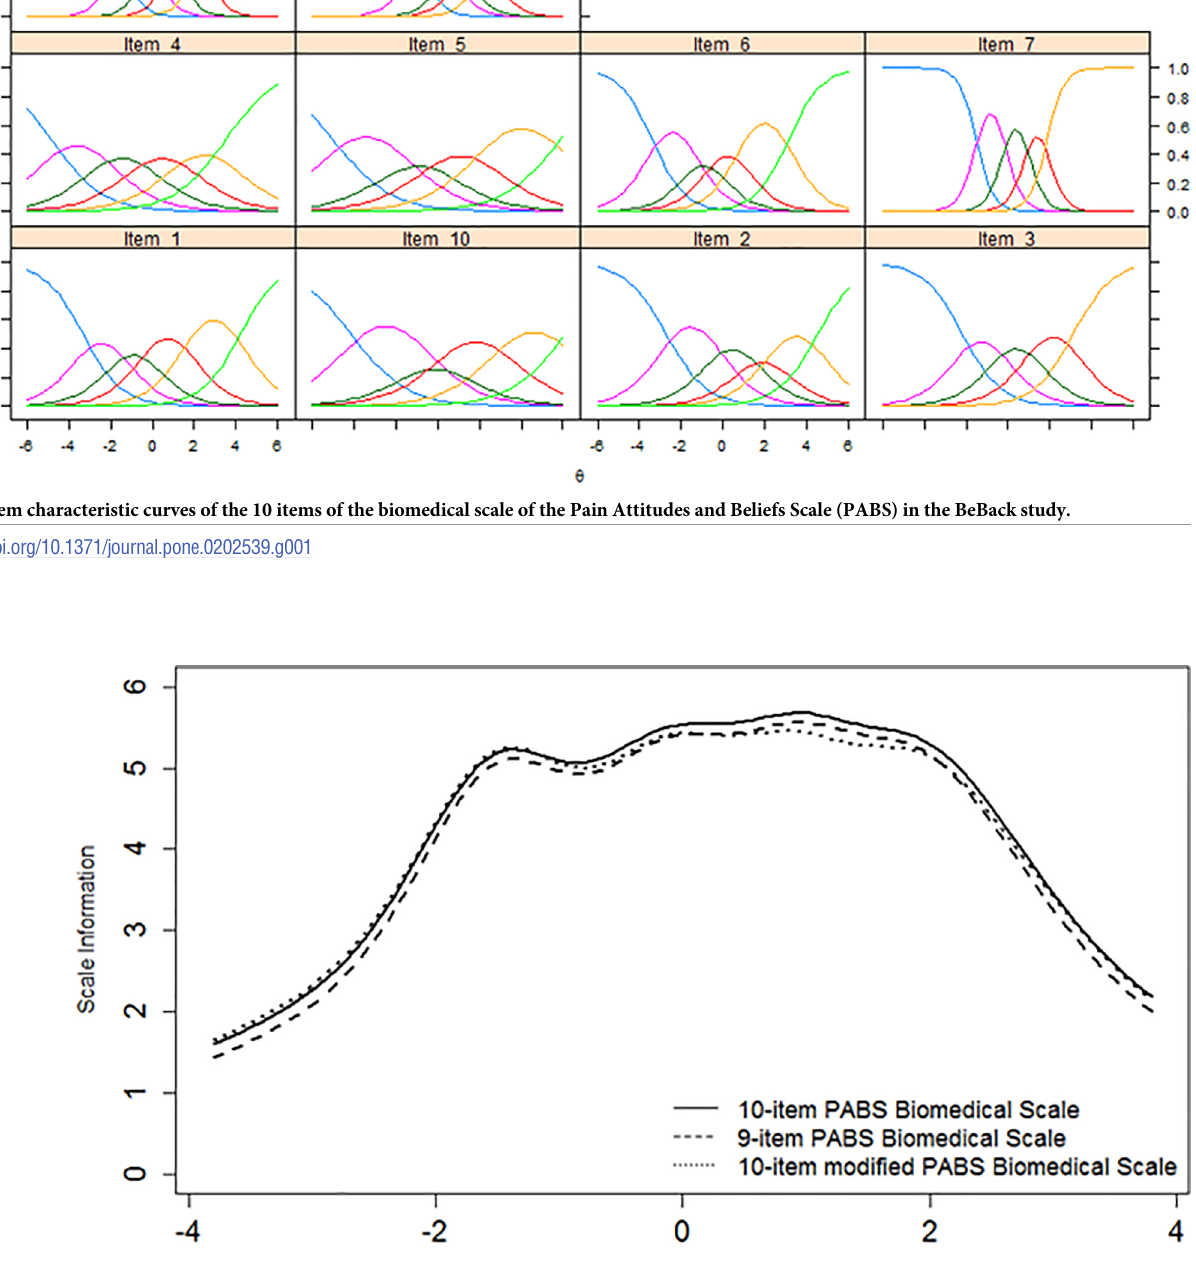
PLOS ONE | https://doi.org/10.1371/journal.pone.0202539 September 12, 2018 10 /